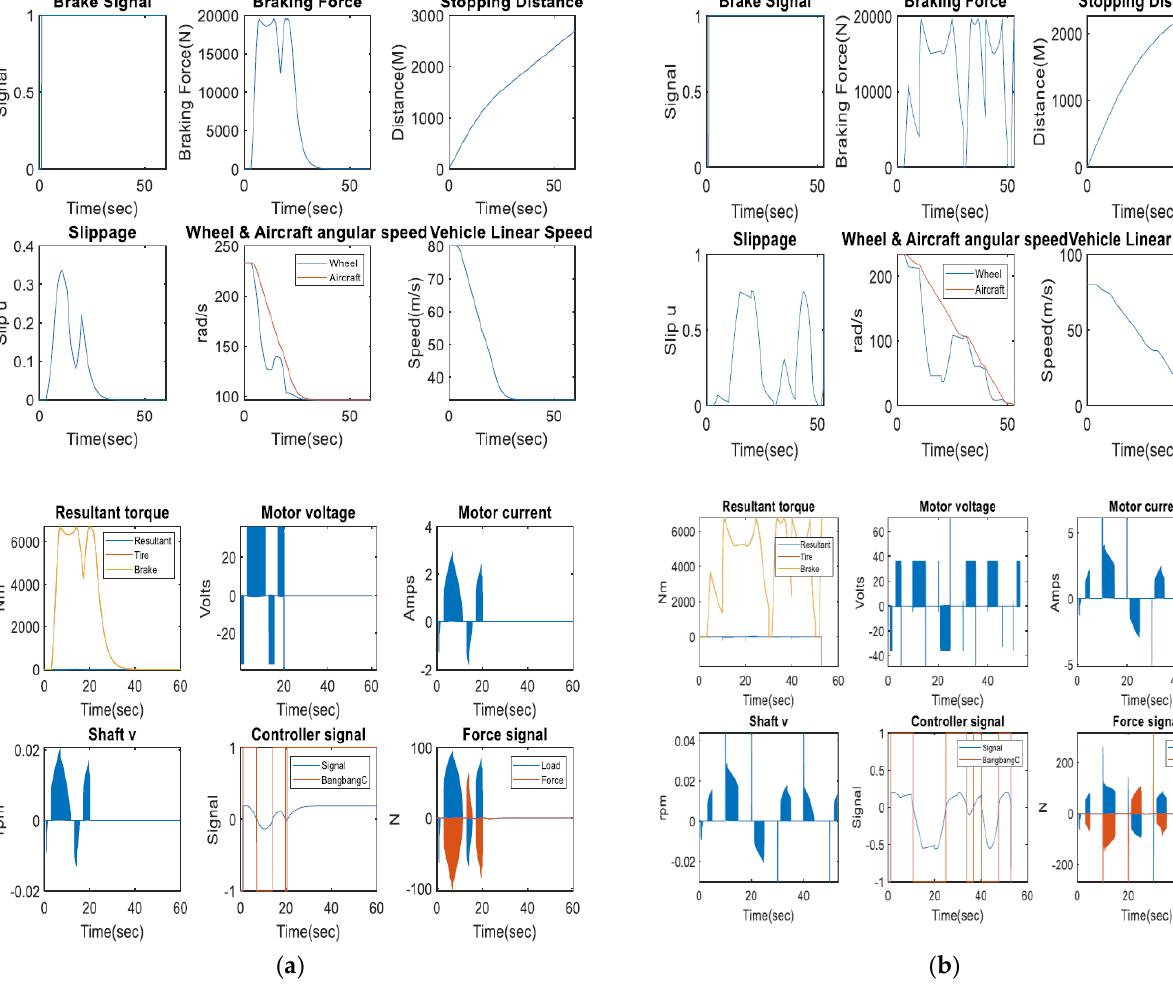
Figure 4. Comparison in Resultant Data from OC and IOC Faults: ( a ) OC Fault Resultant Data; ( b ) IOC Fault Resultant Data.